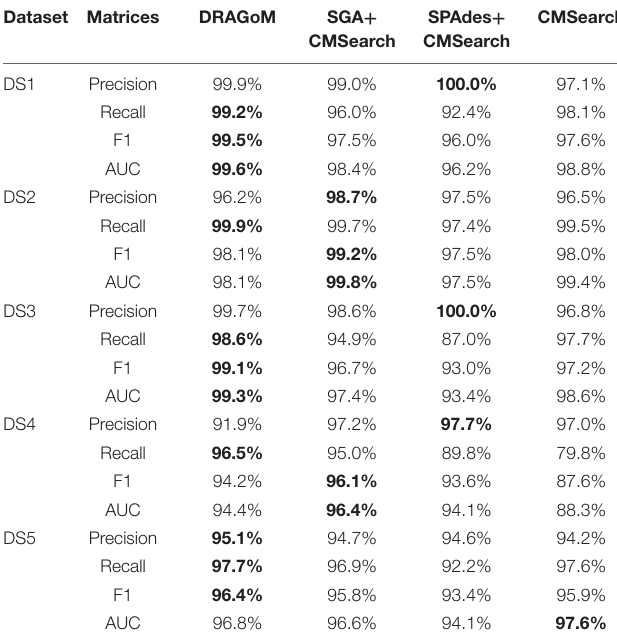
TABLE 3 | Performance summary of the tested methods on DS1–DS5 (for 16S rRNA queries). Dataset